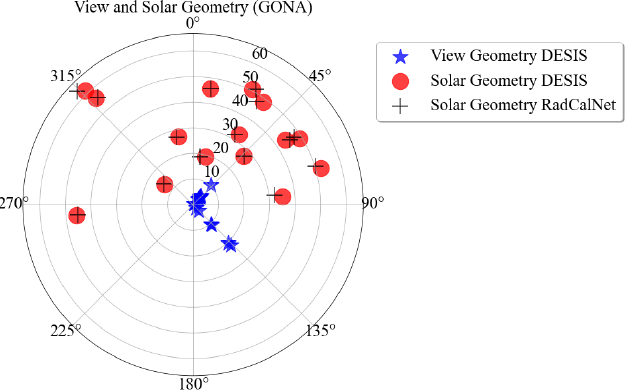
Figure 9. DESIS and RadCalNet acquisition geometry on GONA. The blue symbols represent DESIS viewing geometry, the red symbols represent DESIS solar geometry, and the black symbols represent RadCalNet solar geometry.